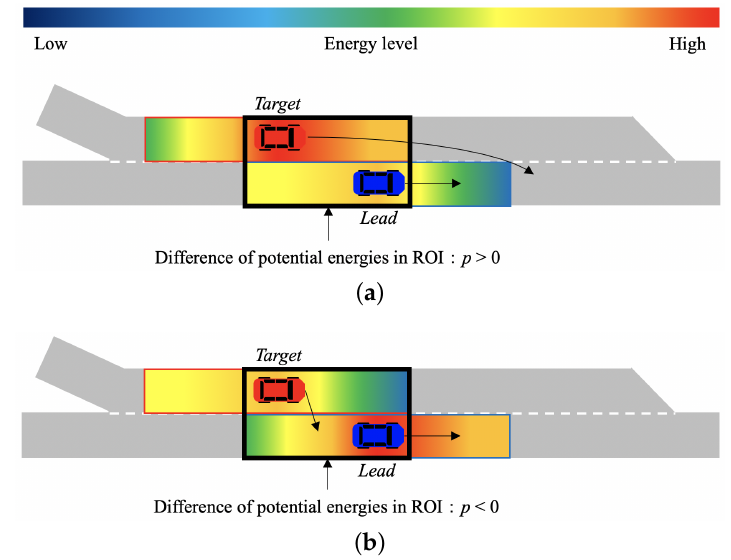
Figure 6. The ROI (region of interest) for the interaction between drivers: the proposed method focuses on the region where two potential fields are overlapped. ( a ) shows the case that the target vehicle accelerates whereas the lead vehicle decelerates for giving passage. Conversely, ( b ) represents the case when the target vehicle is slowing down and cuts-in to the behind space of the lead vehicle. It is confirmed that the potential fields have the different distribution within the ROI.